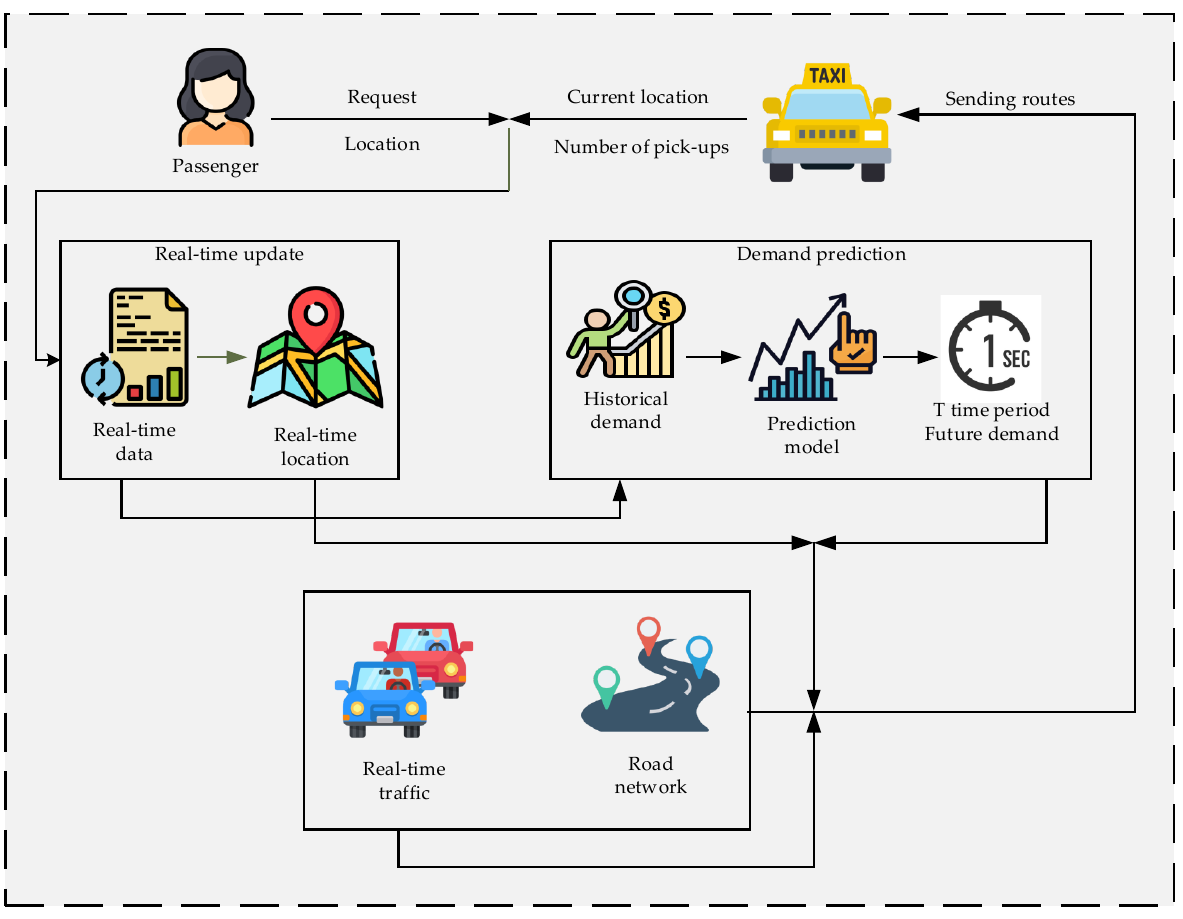
Figure 1. Overview of the regular and ride-hailing taxi services proposed